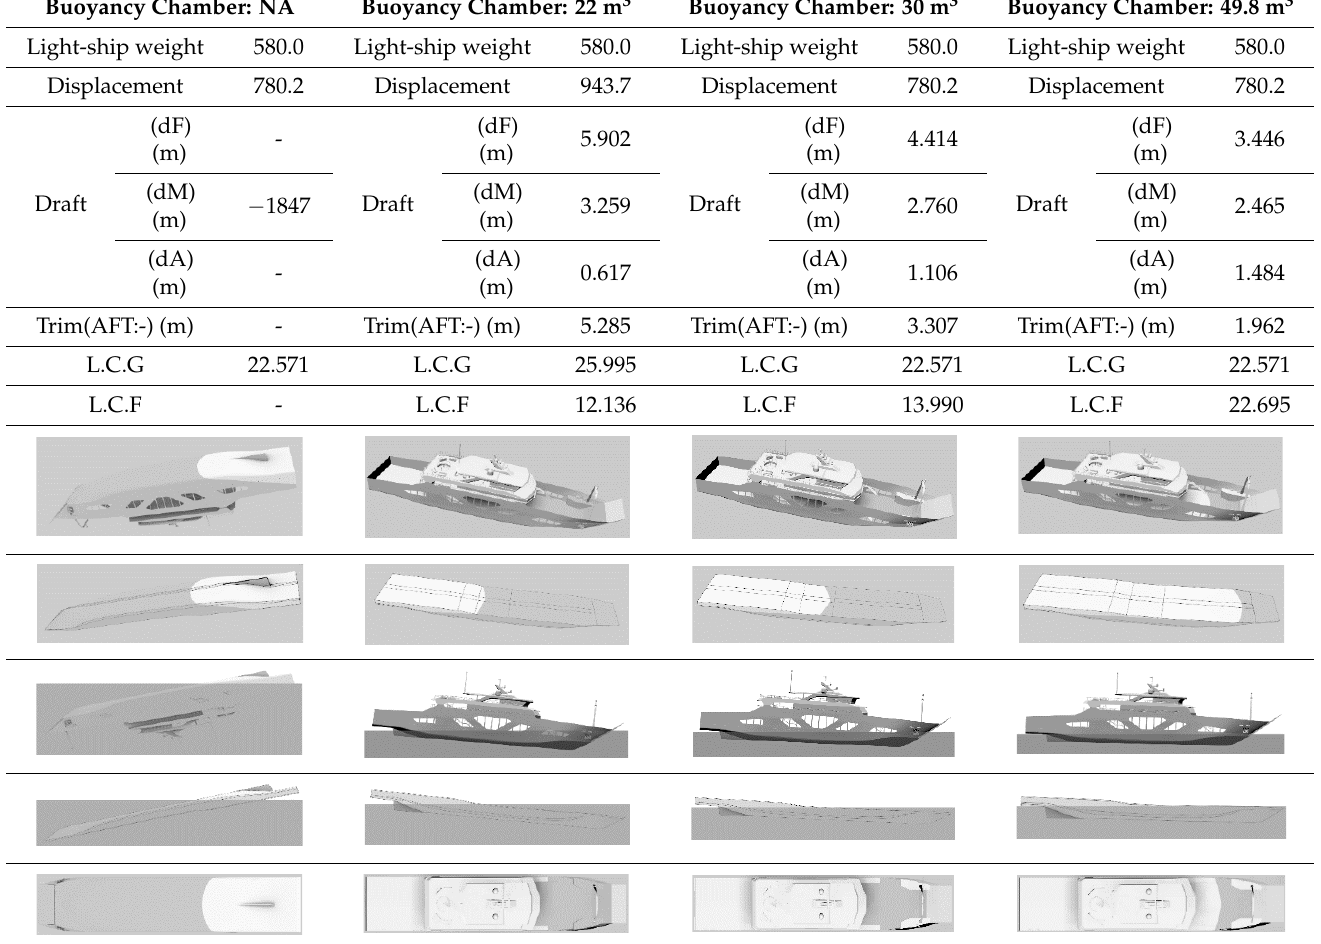
Table 5. Simulation results according to the volume of the buoyancy chamber.